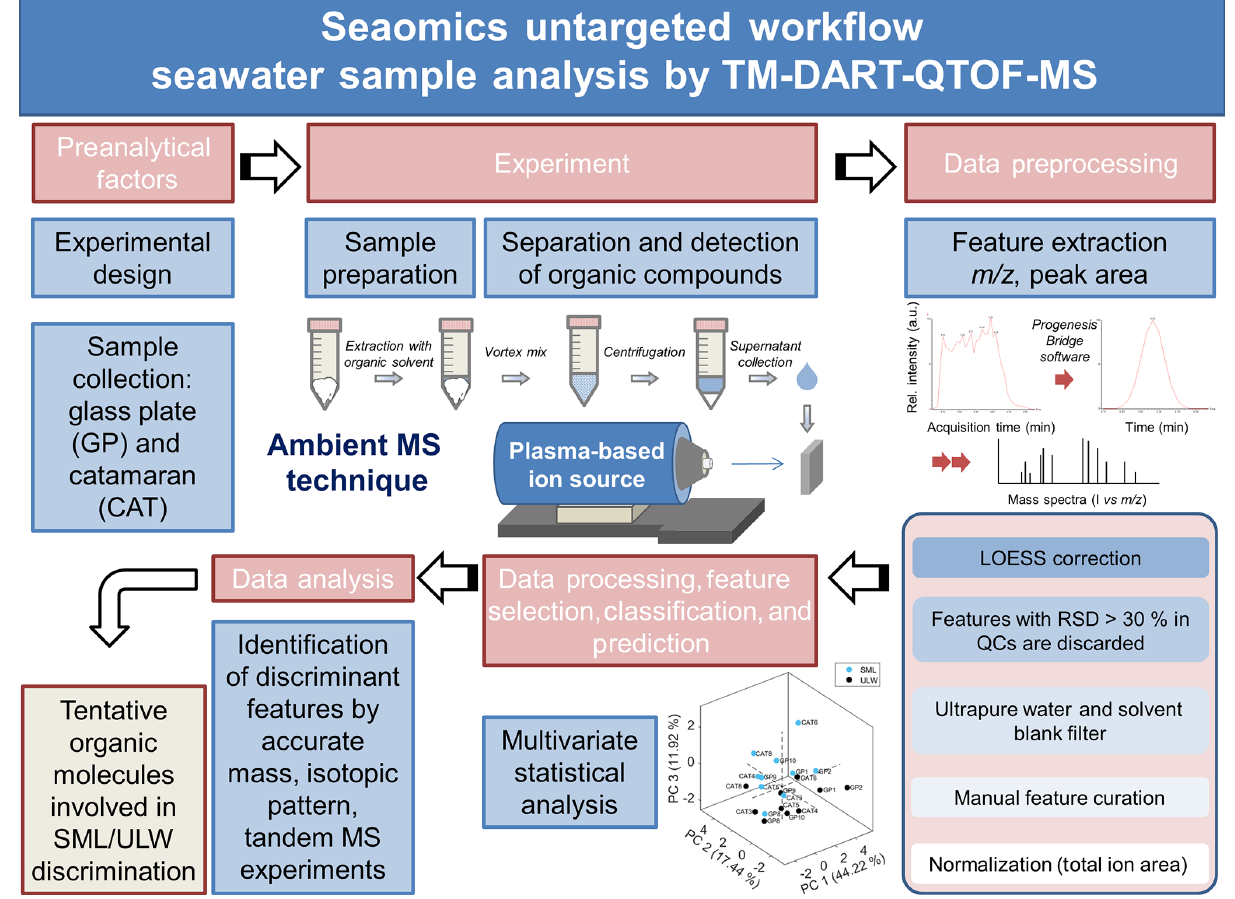
Figure 1. Scheme illustrating the analytical strategy implemented at CIBION-CONICET for the analysis of lyophilized seawater samples using TM-DART-QTOF-MS.